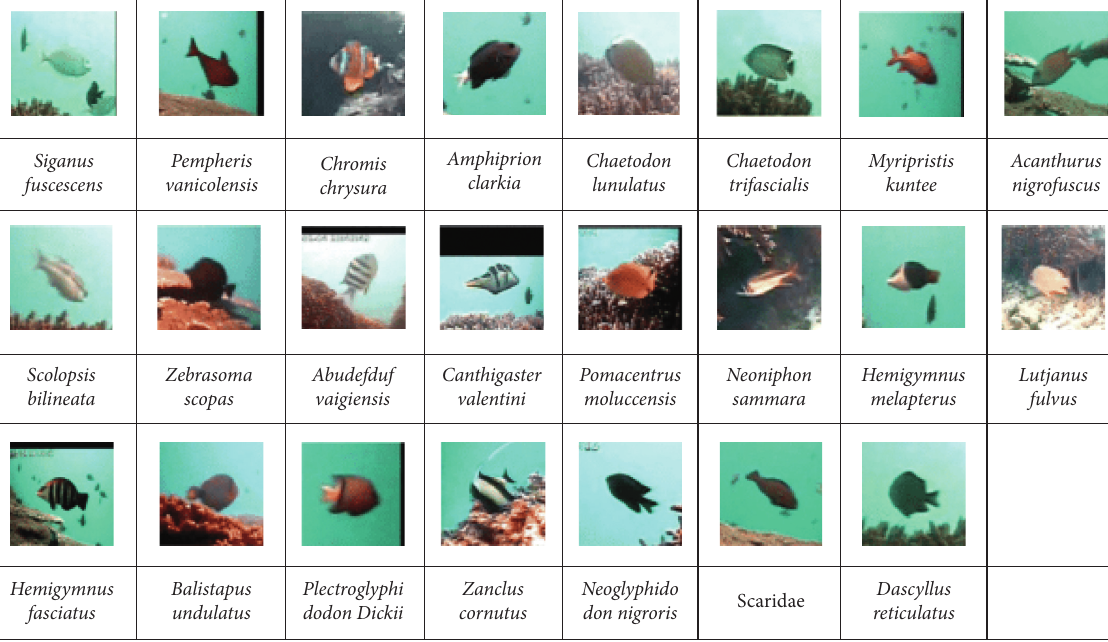
Figure 10: Dataset used in the proposed method contains different kinds of fish. Table 1: Recognition rate comparing with the existing